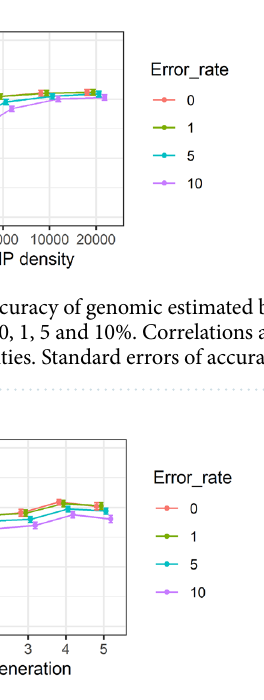
Figure 10. Accuracy of genomic estimated breeding values for five consecutive generation over 0.5, 3, 10 and 20 K SNP densities. Correlations are averaged over different SNP densities, replicates, family types and trait heritabilities. Standard errors of accuracies are shown as error